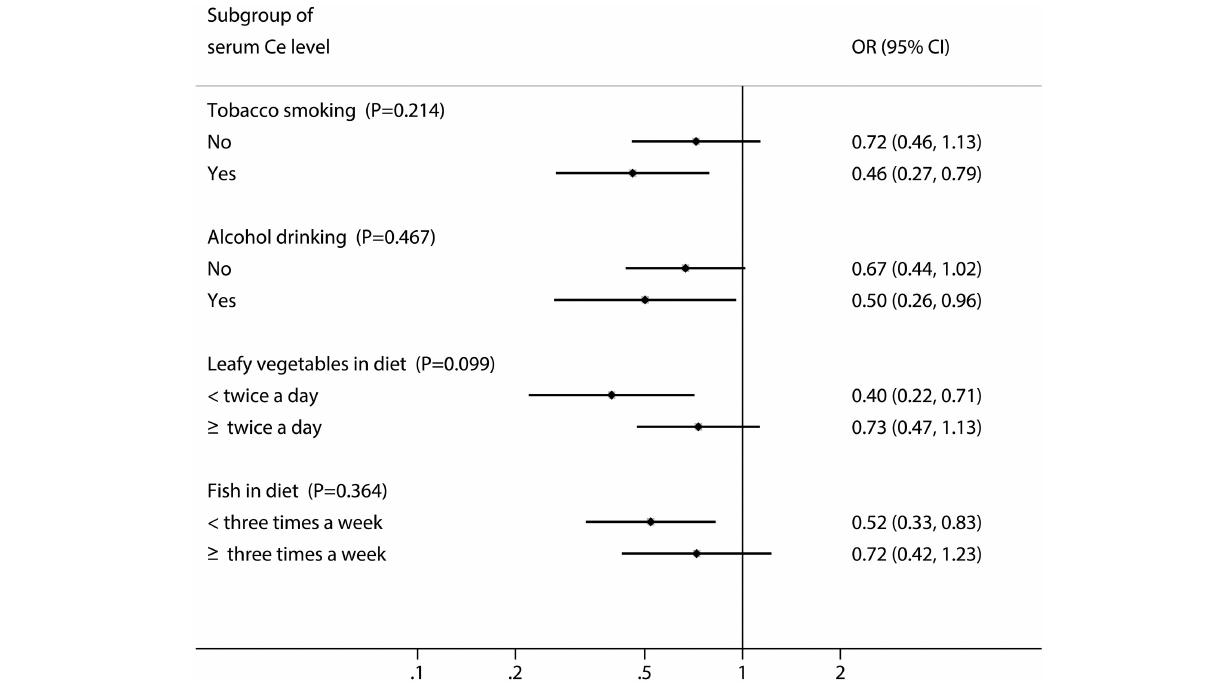
Frontiers in Public Health |